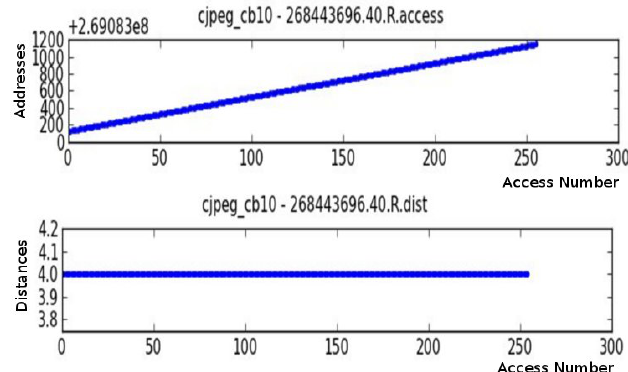
Figure 1: Data memory addresses accessed by an instruc- tion in a cjpeg algorithm run: Absolute (above), and dis- tances